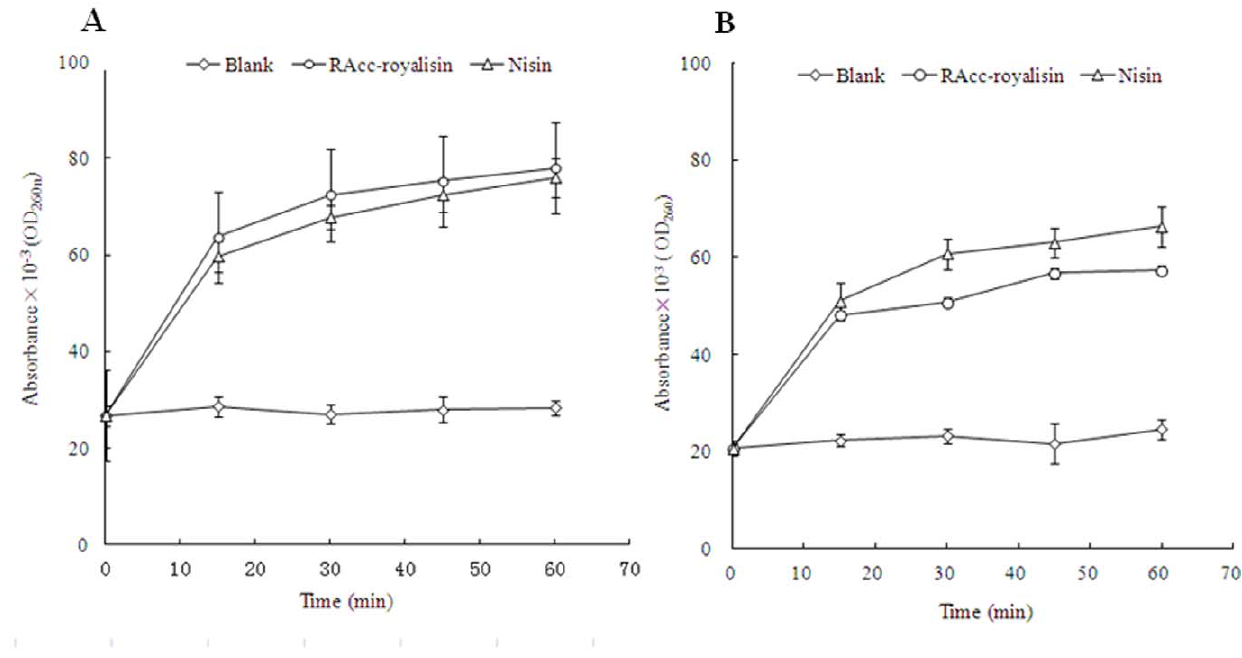
Figure 6. The effect of RAcc-royalisin on the cell membrane of Gram-positive bacteria. The UV absorbance of B. subtilis (A) and M. flavus (B) at 0, 15, 30, 45 and 60 minutes of treatment with RAcc-royalisin, nisin and blank control, respectively.